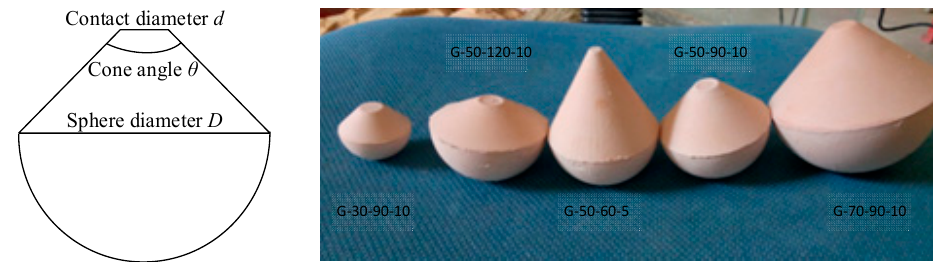
cr and the tensile strength.